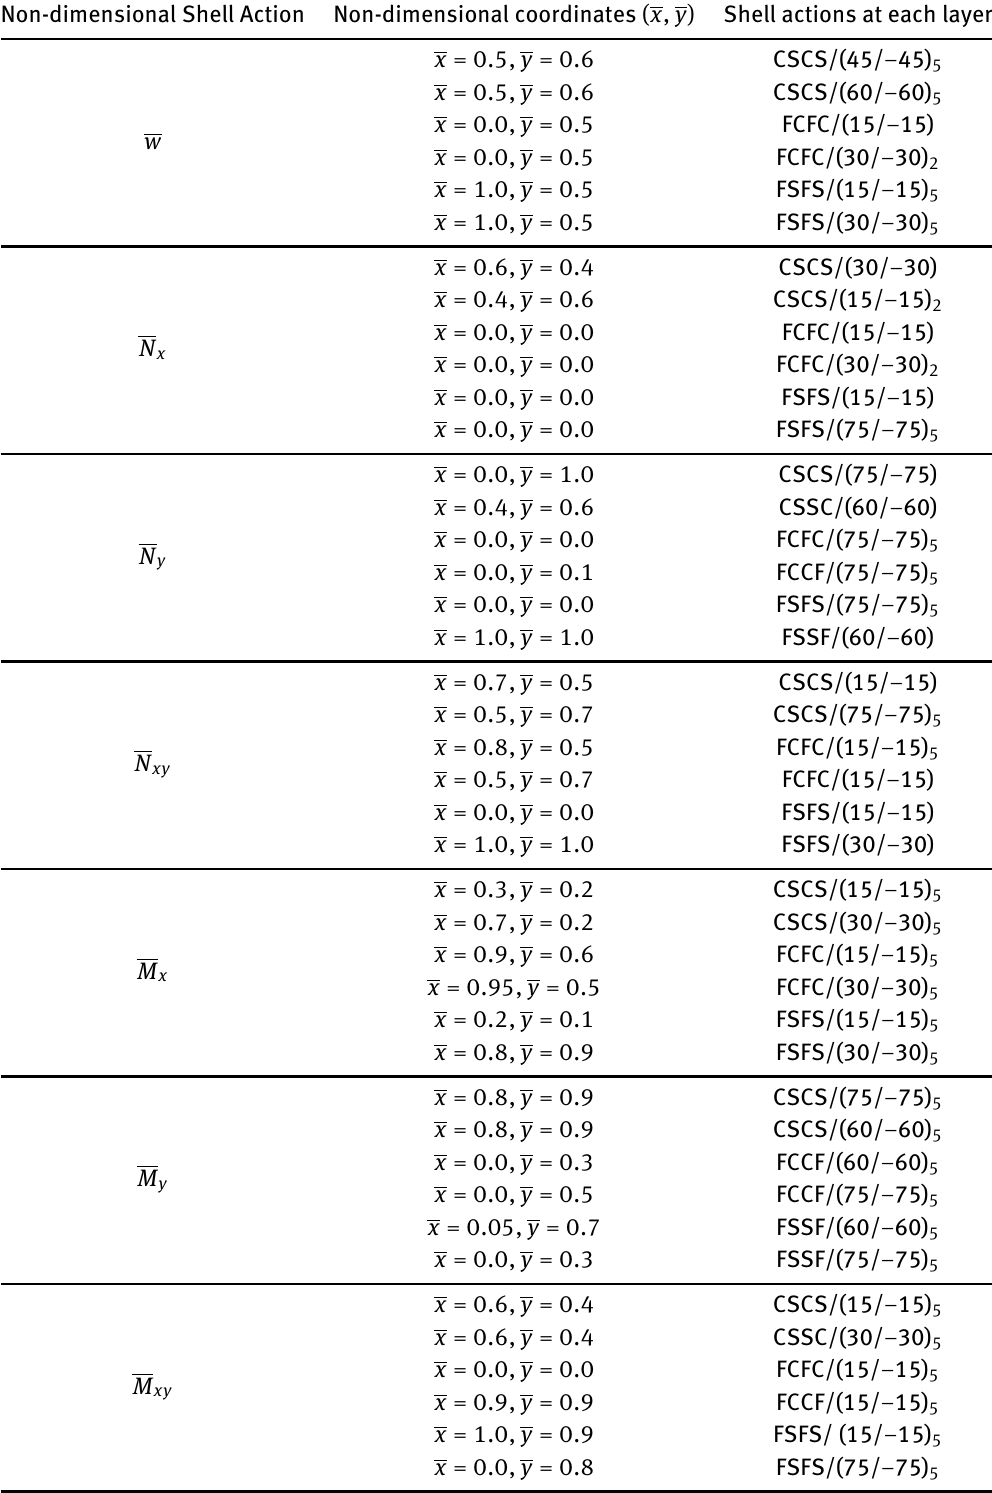
Table 17: Shell options arranged according to ascending order of negative values of shell actions of different anti- symmetric angle ply lamination and boundary conditions of stiffened composite hypar shell with cutout Non-dimensional Shell